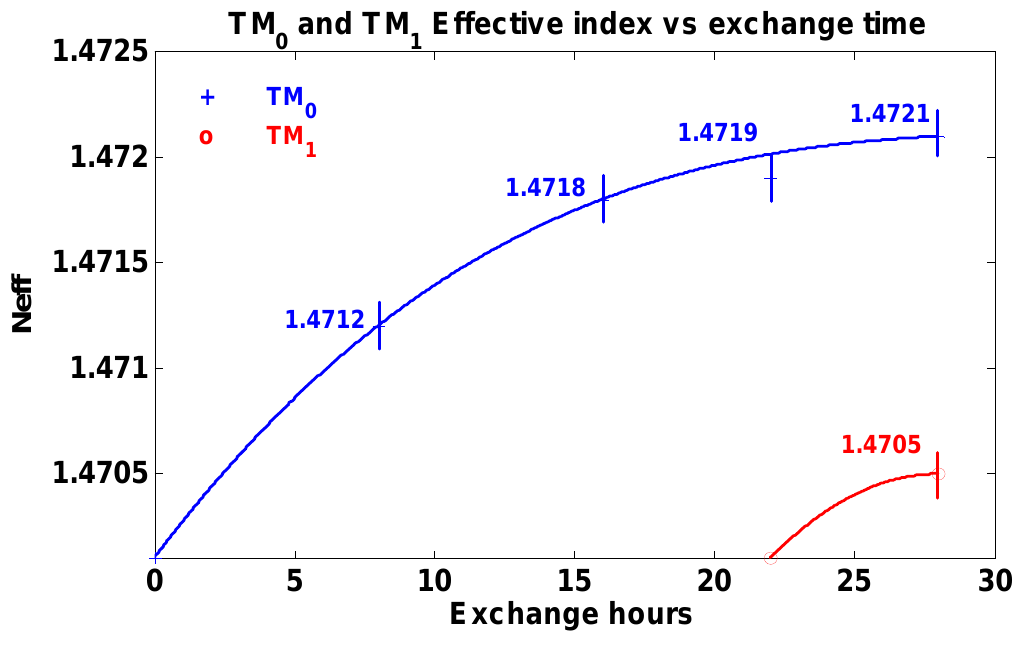
, as a function eff at 400 3